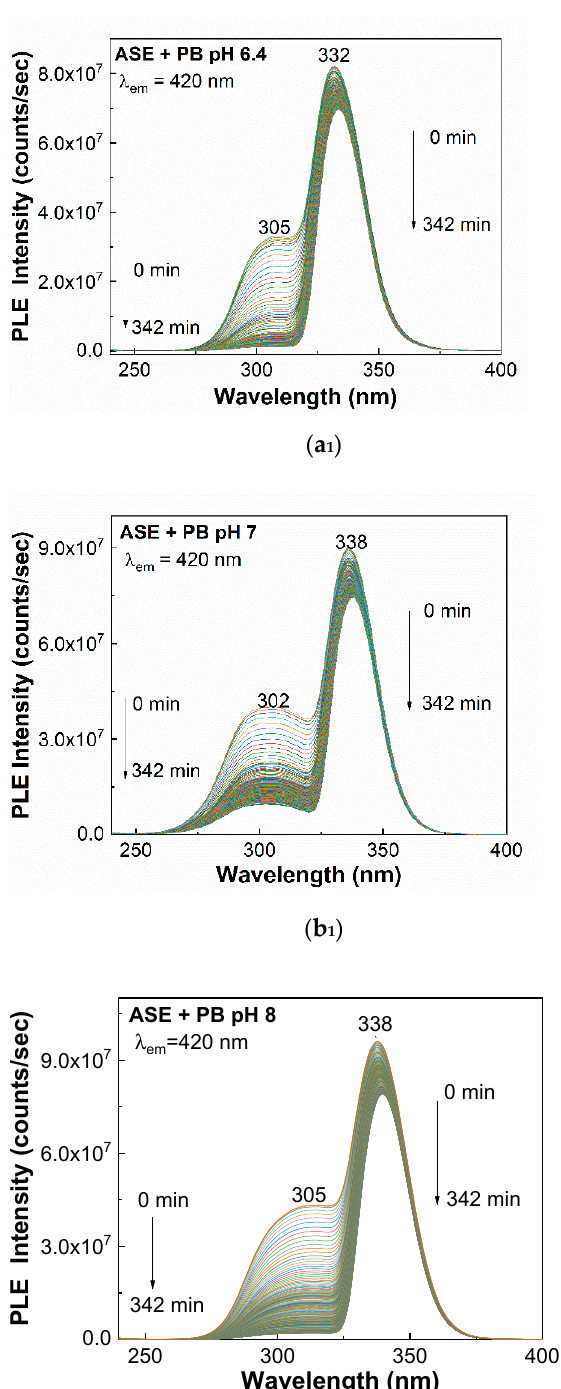
Figure 4 highlights the dependence of the PLE and PL spectra of ASE as function of the PB pH value.